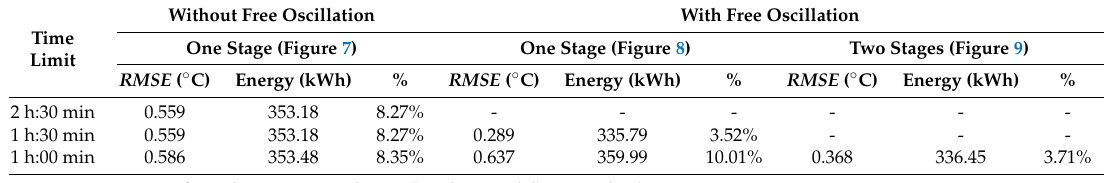
Table 1. Energy balance after applying the different strategies to the real case